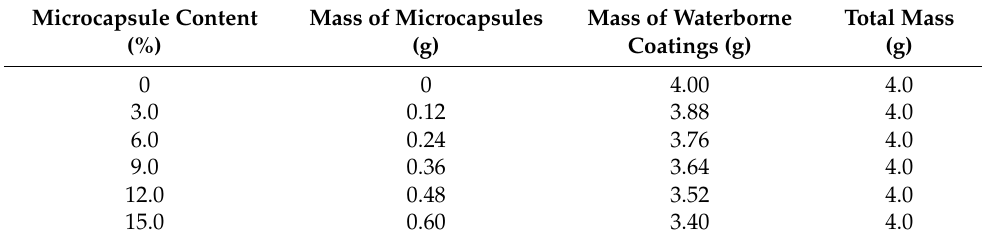
Table 1. Material details of waterborne coatings containing different microcapsules. Microcapsule